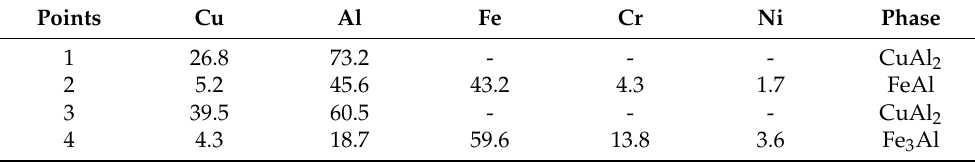
Figure 10. SEM images of Cu and Al surfaces for IFR-600 after peeling test: ( a ) Cu side, ( b ) Al side, ( c , d ) enlarged images of the circles in the ( a , b ). Table 3. Chemical composition of corresponding points at the peeling surface of IFR-600 (at. %). Points